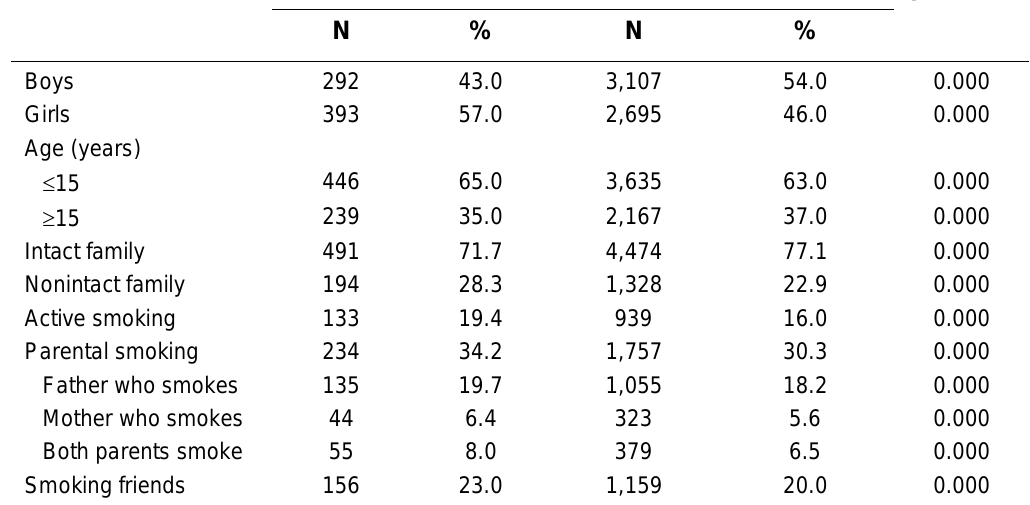
Percentages of Gender, Age, Family Structure, Active Smoking, Parental Smoking, and Smoking Friends among Adolescents With and Without Asthma (6,487 Adolescents) Asthmatics (n = 685)